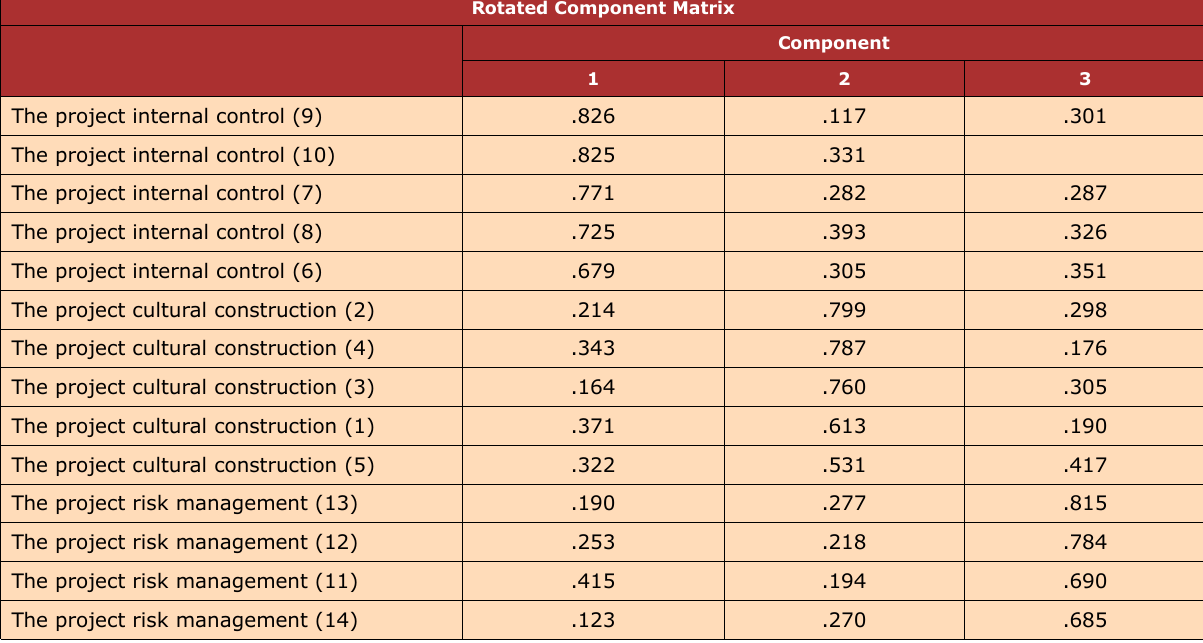
Table 6. Factor analysis of conformed